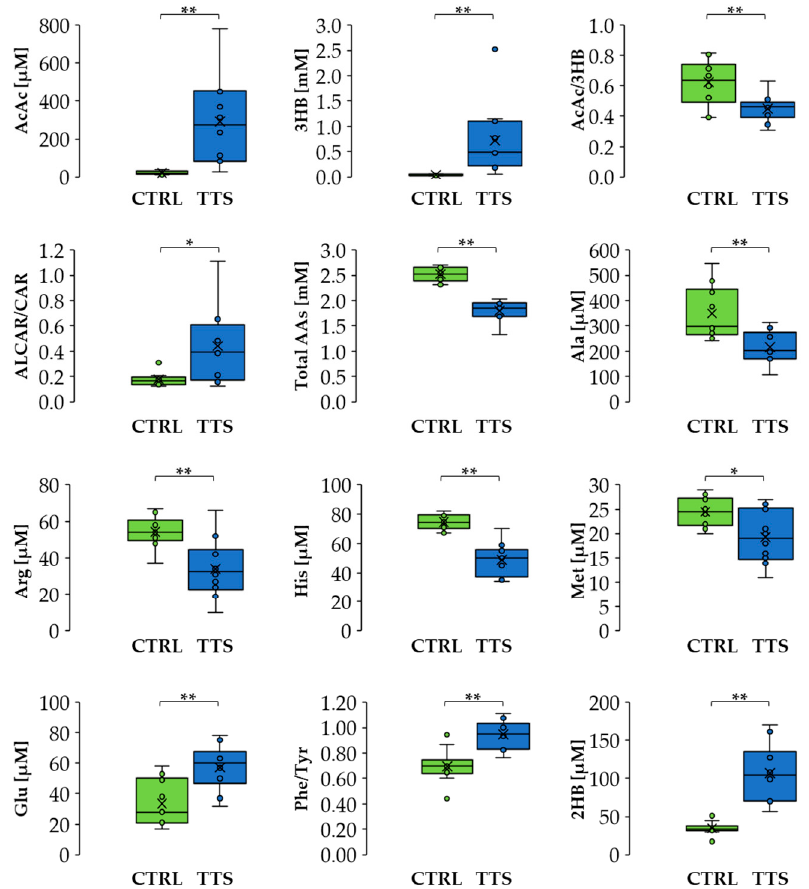
Figure 3. Differences in metabolite levels and ratios between CTRL and TTS. Boxes denote IQR, lines denote median, whiskers denote the 5th and 95th percentile, and x denotes the average. * p < 0.05, ** p < 0.01. Abbreviation used: AcAc: acetoacetate; 3HB: 3 ‐ hydroxybutyrate; ALCAR: acetyl ‐ L ‐ carnitine; CAR: L ‐ carnitine; Ala: alanine; Arg: arginine; His: histidine; Met: methionine; Glu: glutamate; Phe: phenylalanine; Tyr: tyrosine; 2HB: 2 ‐ hydroxybutyrate.